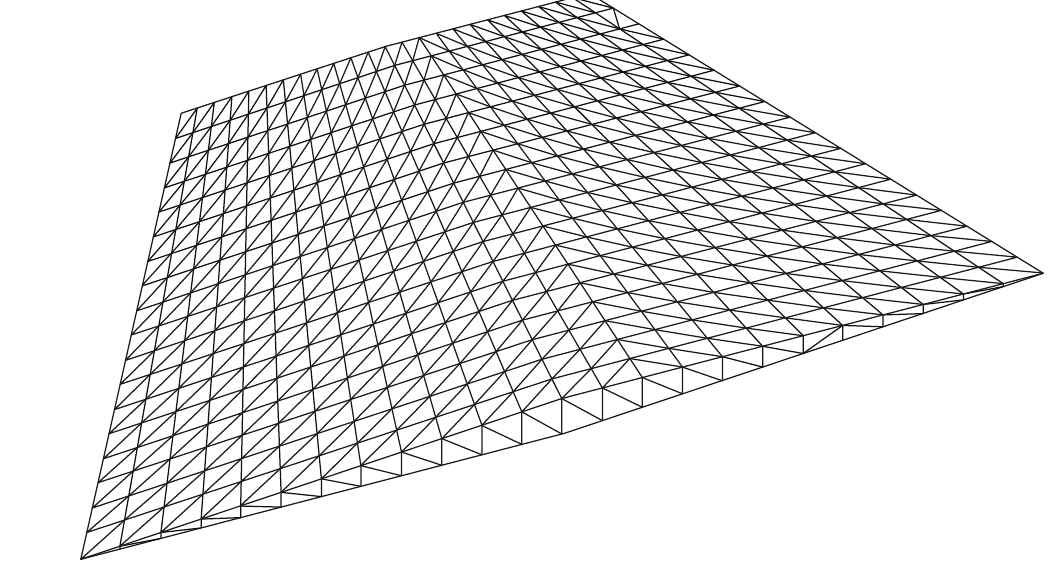
Figure 4: Finite element model of control surface.